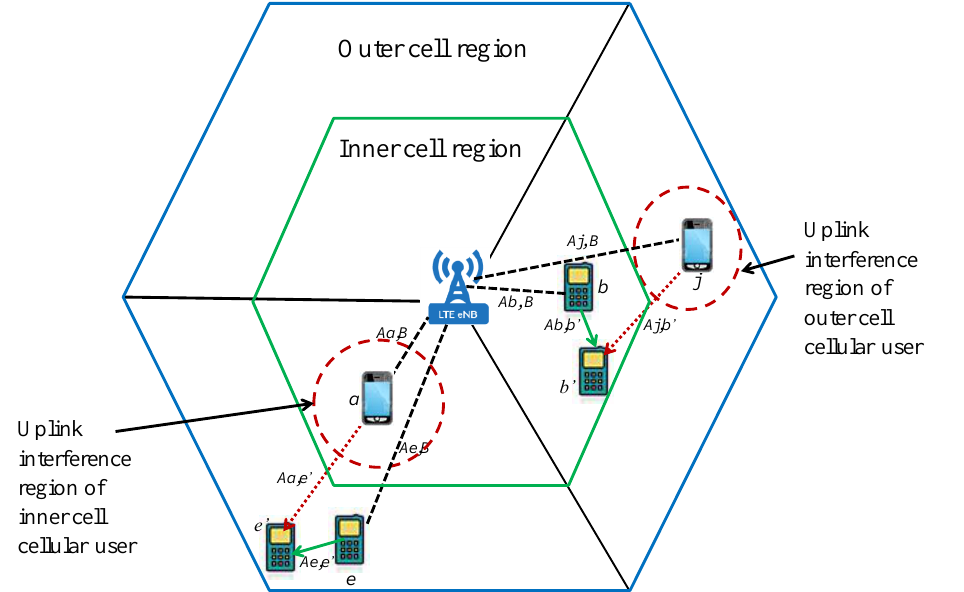
Figure 4. Uplink interference regions of cellular users.